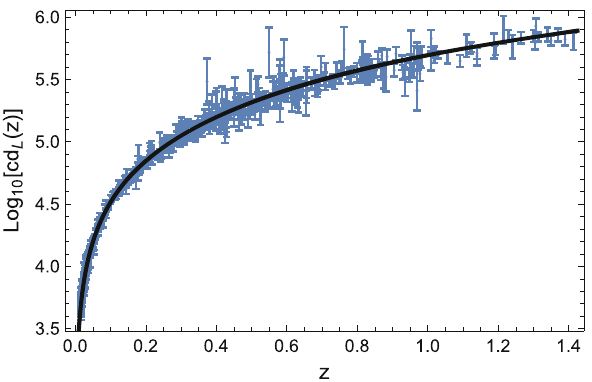
Fig. 5 Observed SNeIa Hubble free luminosity distance data along with the fitted curve for the best fit parameter value μ ∼ 0 . 39. χ 2 / d . o . f = χ 2 /( N − n ) ∼ 0 . 93 and therefore the fitting is good min min